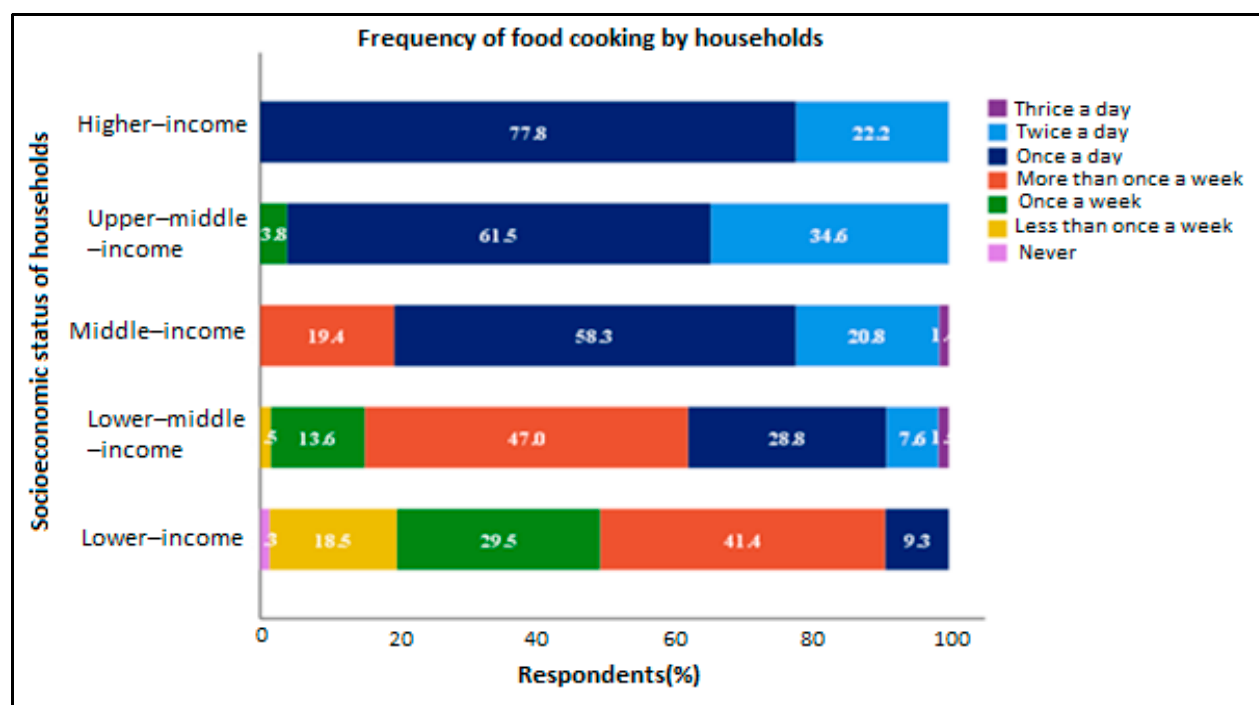
Figure 2. How often households cooked food at home.